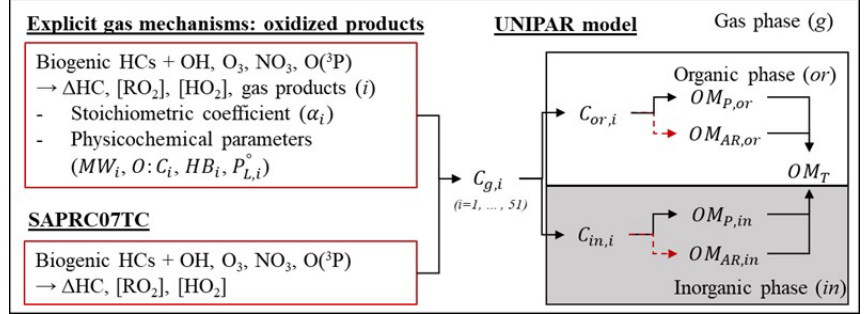
Figure 1. The model structure of the UNIPAR model coupled with the SAPRC07TC gas mechanism with model parameters originated from the explicit gas mechanisms. The lumping species and their model parameters were estimated by simulating the explicit gas mechanism and applied to the UNIPAR model simulation. C g ,i , C or ,i , and C in ,i are the concentration of lumping species ( i ) in the gas phase (g), organic phase (or), and inorganic phase (in). OM p , or and OM p , in are the SOA mass generated via gas–particle partitioning in organic (or) and inorganic (in), respectively. OM AR , or and OM AR , in are the SOA mass generated via in-particle chemistry in or and in,